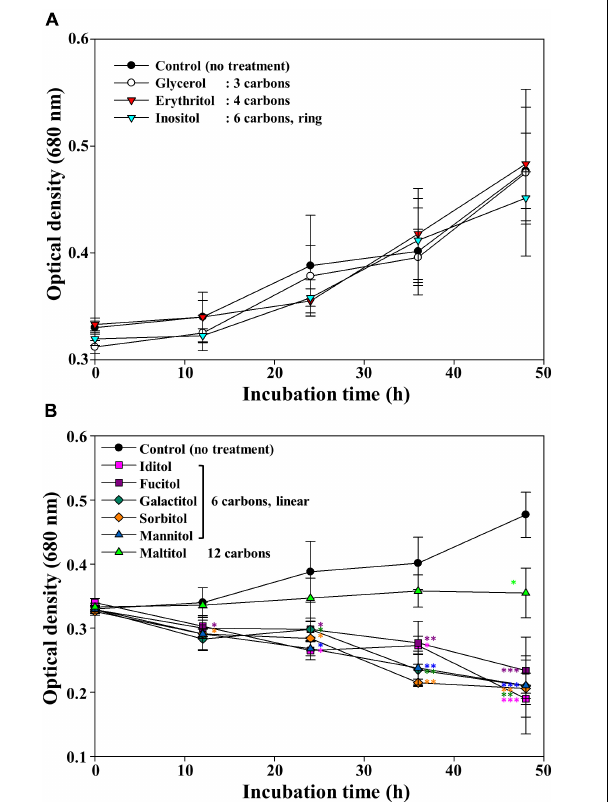
FIGURE 2 | The growth of Microcystis aeruginosa NIES-298 treated with sugar alcohols without any effect (A) and with inhibiting effect on the growth (B) . After adding sugar alcohols (50 µ M), the cultures were incubated at 25 ◦ C under 40 µ mol photons m − 2 · s − 1 with a 12 h/12 h light/dark cycle. Numbers in the parenthesis indicate the carbon numbers of sugar alcohols. Data are indicated as mean values ± standard deviations. Statistical significances depending on sugar alcohols were calculated compared to the control group (no treatment) and their significant differences were indicated with different colors. ∗ p < 0.05; ∗∗ p < 0.01; ∗∗∗ p <